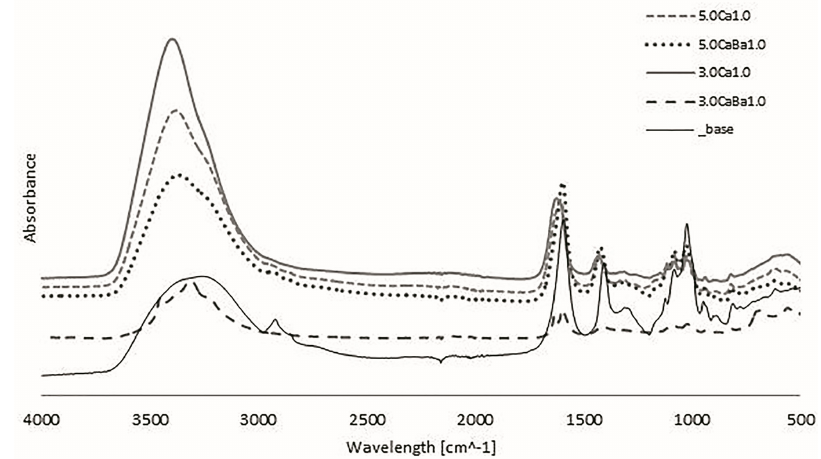
Figure 5. FTIR (Fourier Transform Infrared Spectroscopy) spectrum analysis for alginate samples.